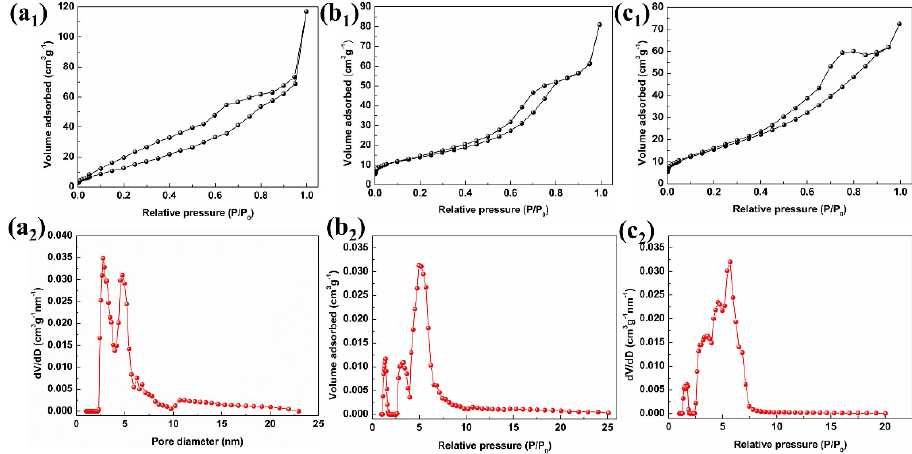
Figure 4. Typical N 2 adsorption/desorption isotherms and pore size distribution curves of ( a ) 18-In 2 O 3 , ( b ) 24-In 2 O 3 and ( c ) hierarchical 48-In 2 O 3 . ( b ) 24-In 2 O 3 and ( c ) hierarchical 48-In 2 O 3